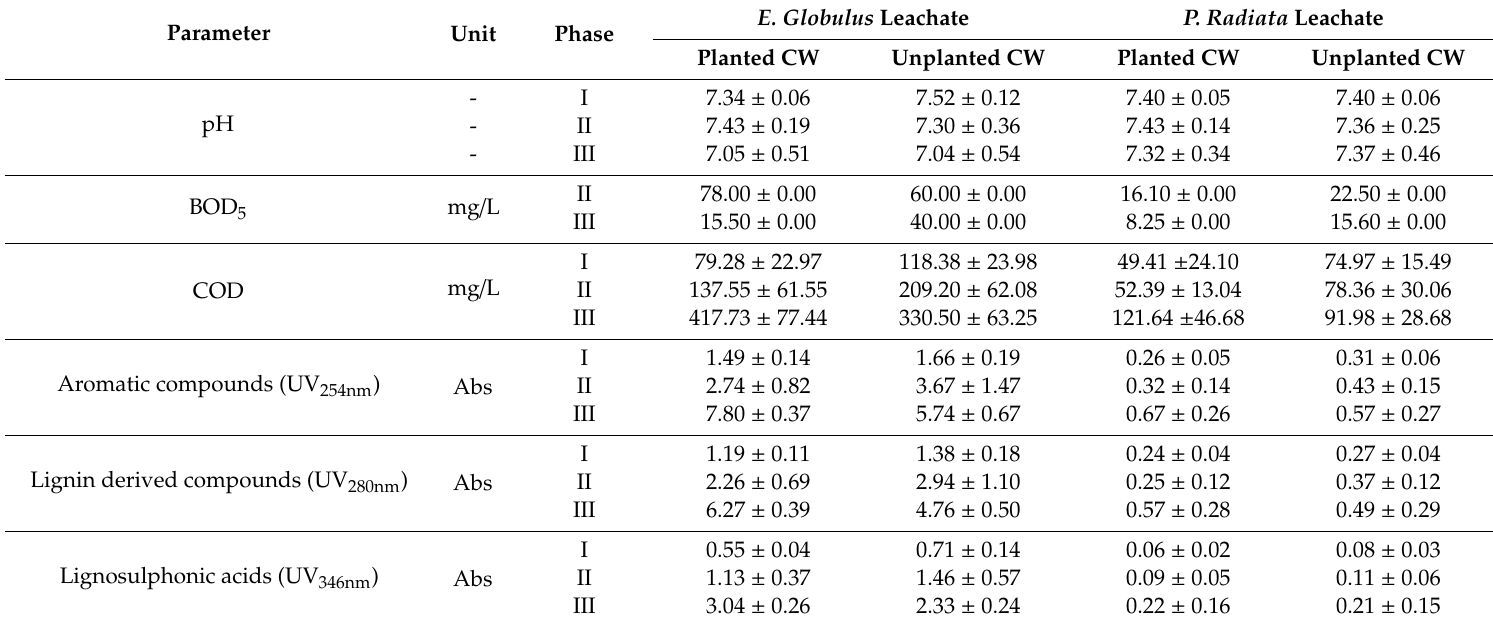
Table 2. Physico-chemical characteristics of the Constructed Wetlands (CW) e ffl uents treating P. radiata and E. globulus